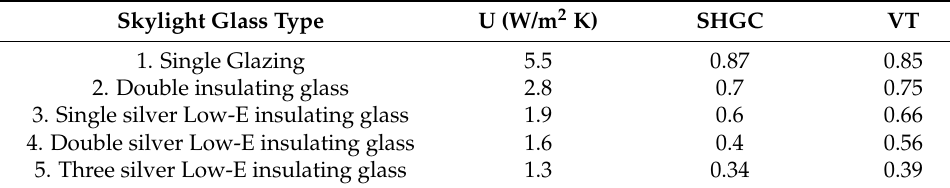
Table 5. Skylight glass detailed parameters.